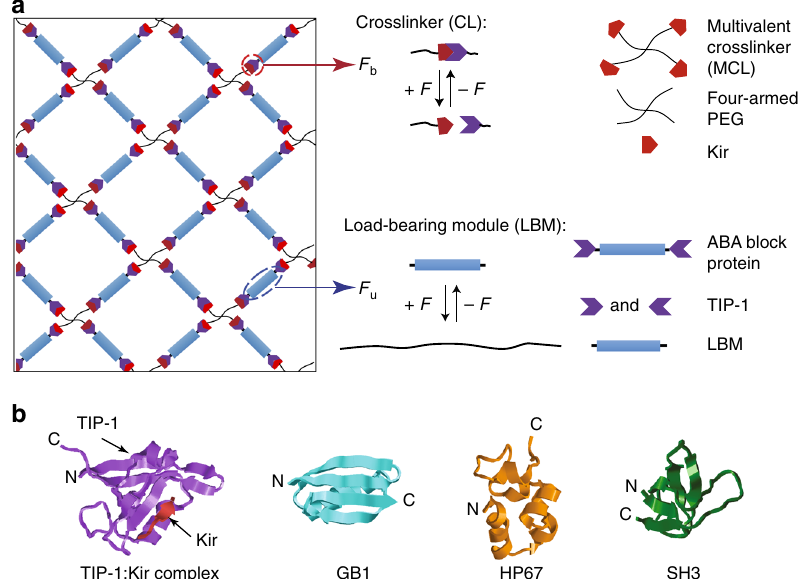
Fig. 1 Schematic of the hydrogel network design. a The hydrogel network is formed from two basic mechanical responsive elements: crosslinkers (CLs) and load-bearing modules (LBMs). The binding/unbinding kinetics of the CL and the folding/unfolding of the LBM are regulated by force. b The structure of the protein domains used in the hydrogel design. TIP-1:Kir complex (PDB: 3DJ1), GB1 (PDB: 3GB1), HP67 (PDB: 2RJY), and SH3 (PDB: 1PRL). The structures are generated using